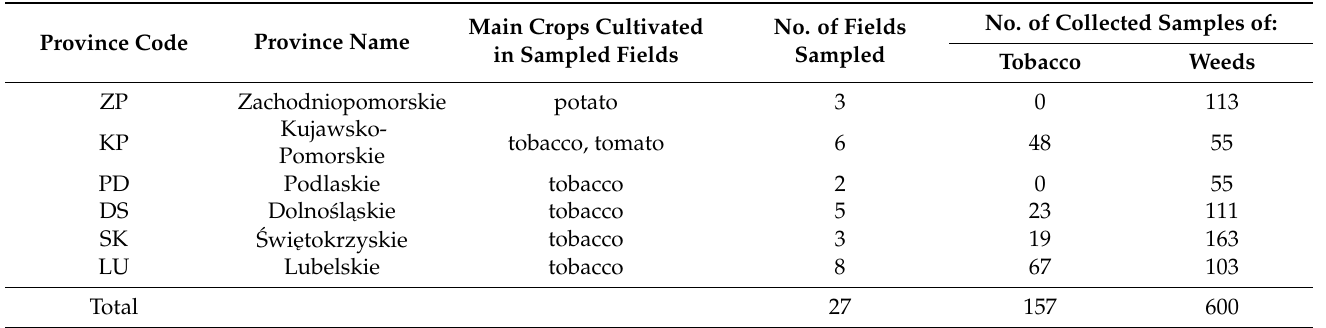
Table 1. The number of sampled fields and plants from six provinces in Poland included in this survey. Province